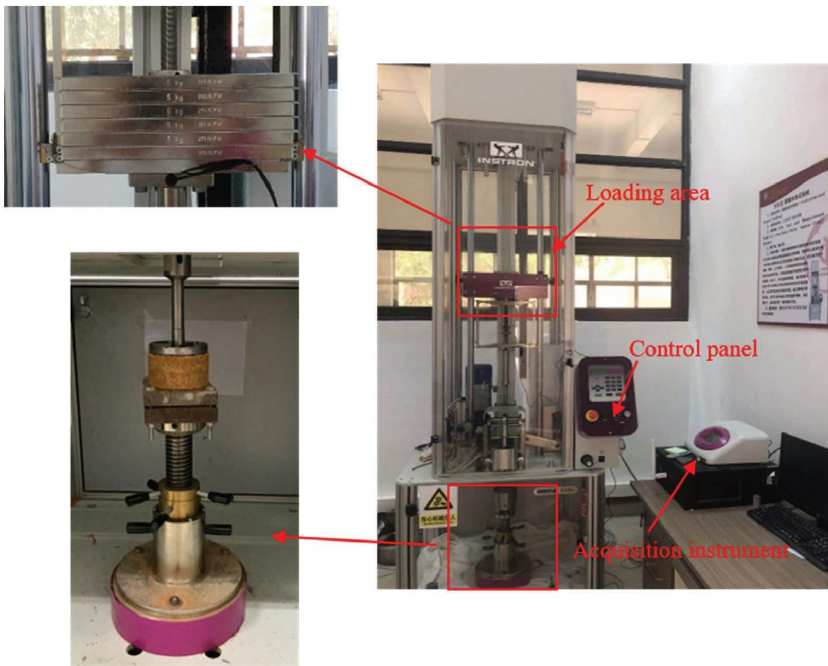
Figure 5: drop-weight